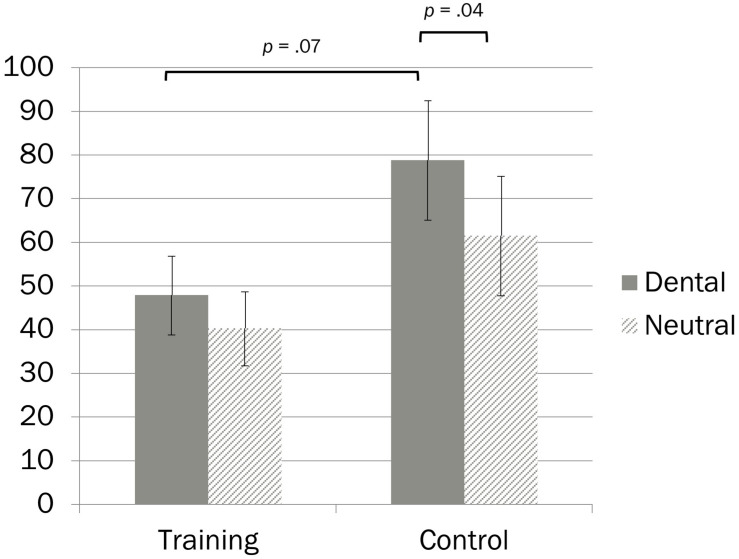
Cue dependency scores (milliseconds) as a function of experimental condition and cue type. Error bars represent 1 SE.